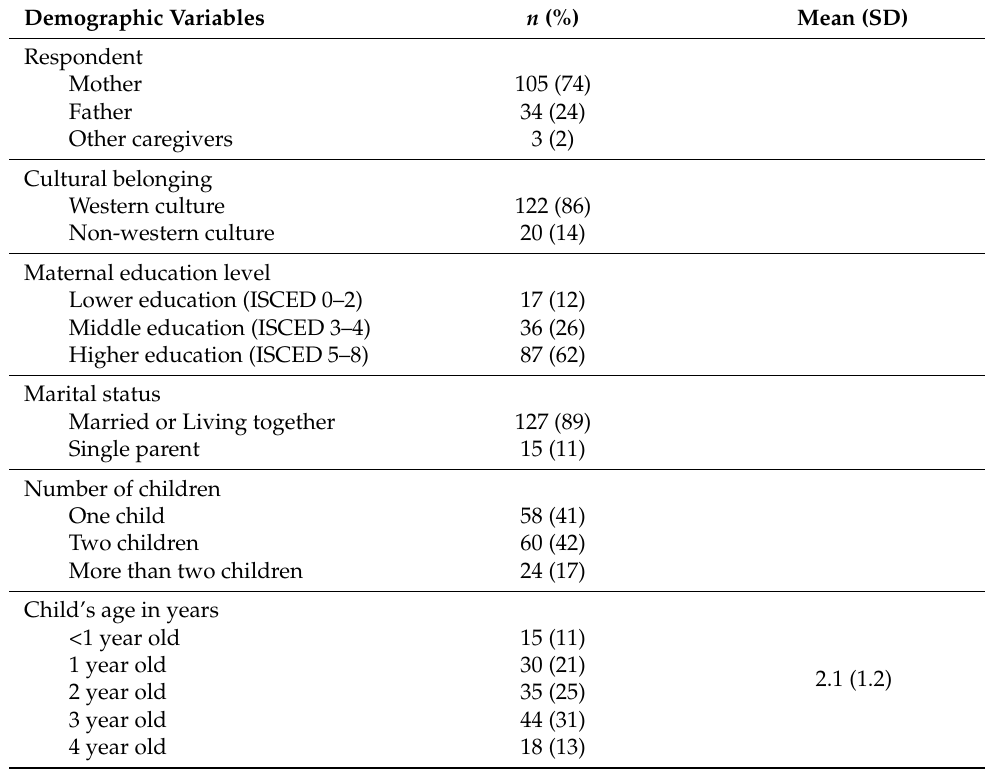
Table 1. Description of the study